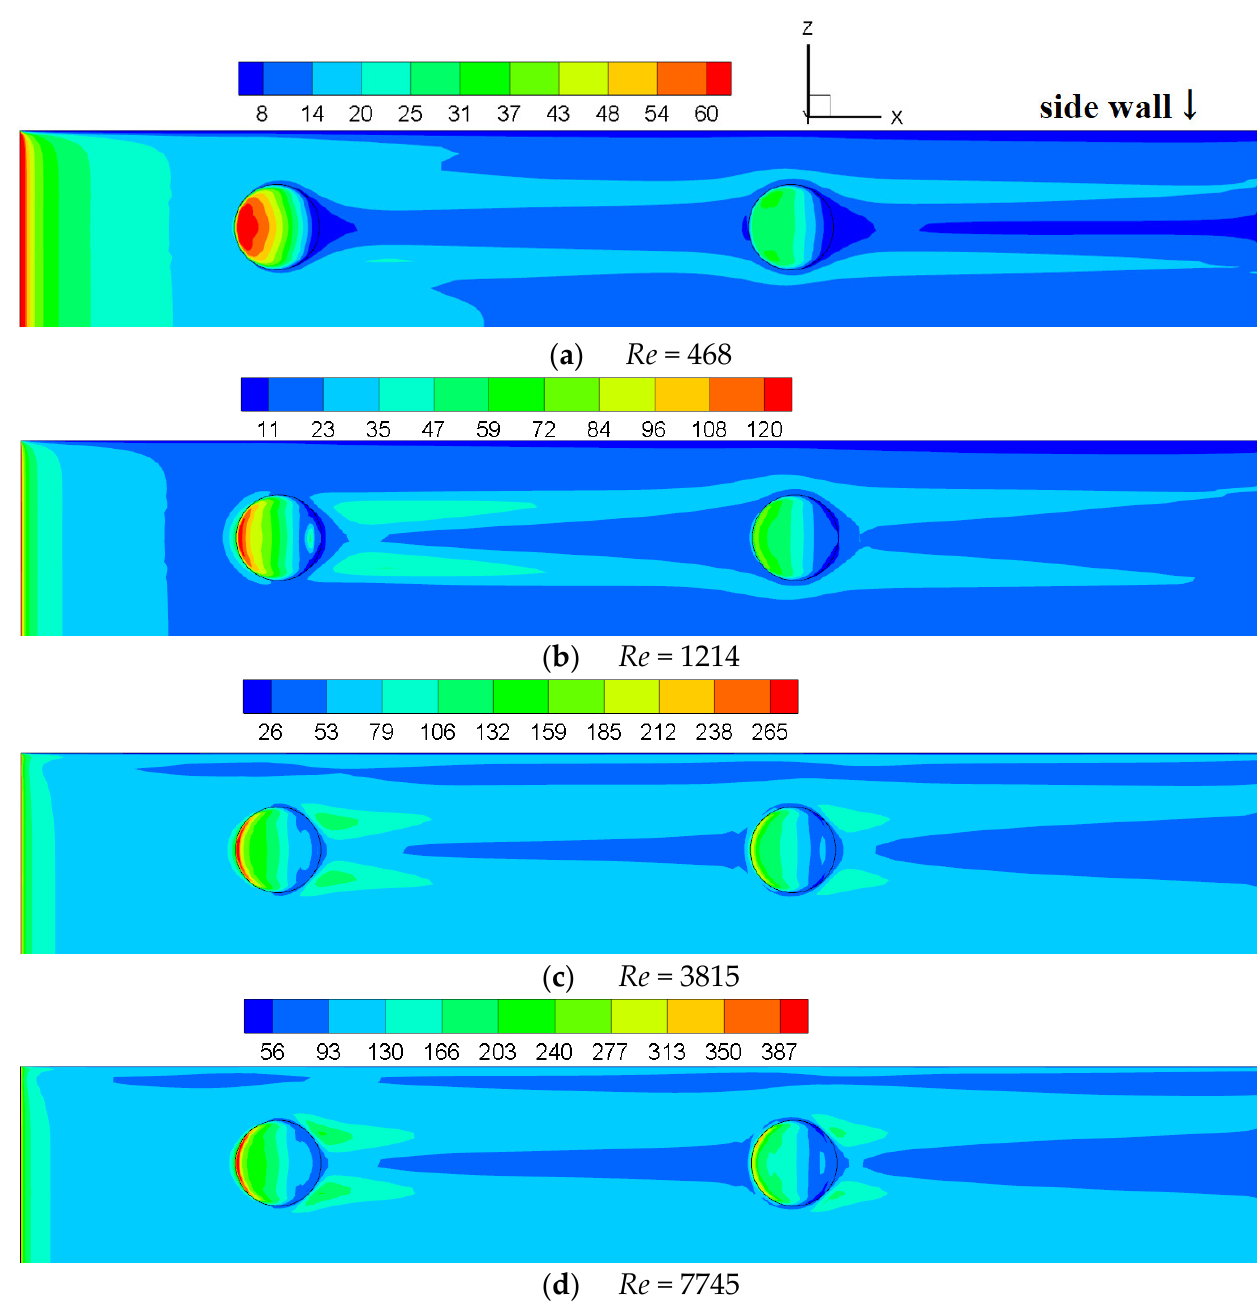
Figure 28. Nusselt number contours on the primary wall and the first and second rows of protru- sions.